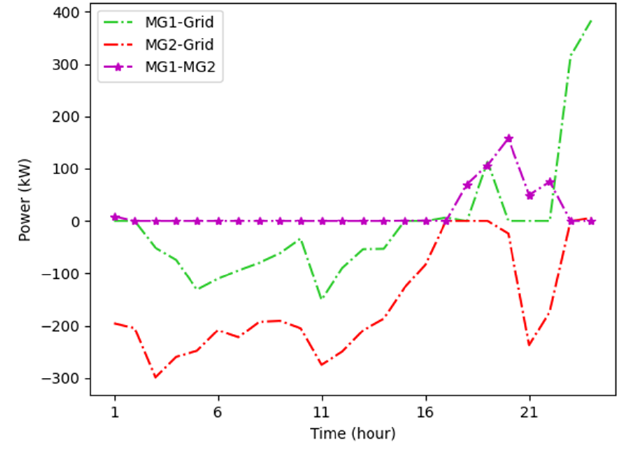
Figure 12. Electric power trading.